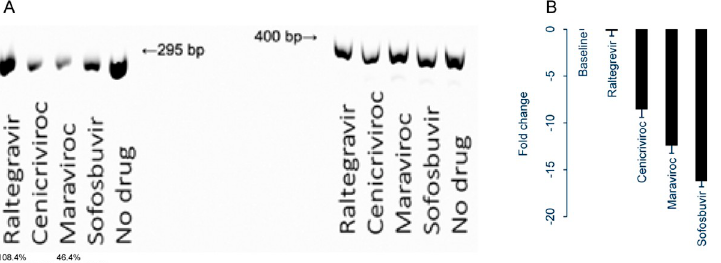
Fig 2. HCV RNA detection after antiviral exposure. Huh7.5 JFH1 cells were exposed to 0–25 ug/mL of sofosbuvir, cenicriviroc, maraviroc, or raltegravir for 24 hours. (A) HCV negative-strand RNA (left) and GAPDH (right) were detected by qualitative RT-PCR in cell lysates, and (B) HCV positive-strand RNA in supernatant was expressed as reduction (fold change) over 24